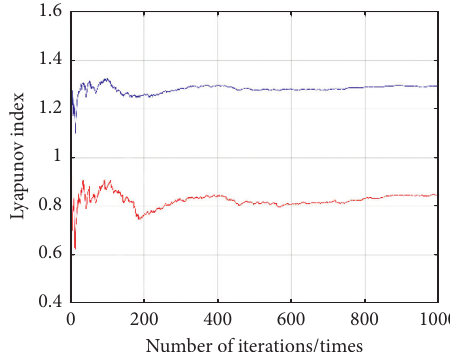
Figure 5: Spectra of Lyapunov